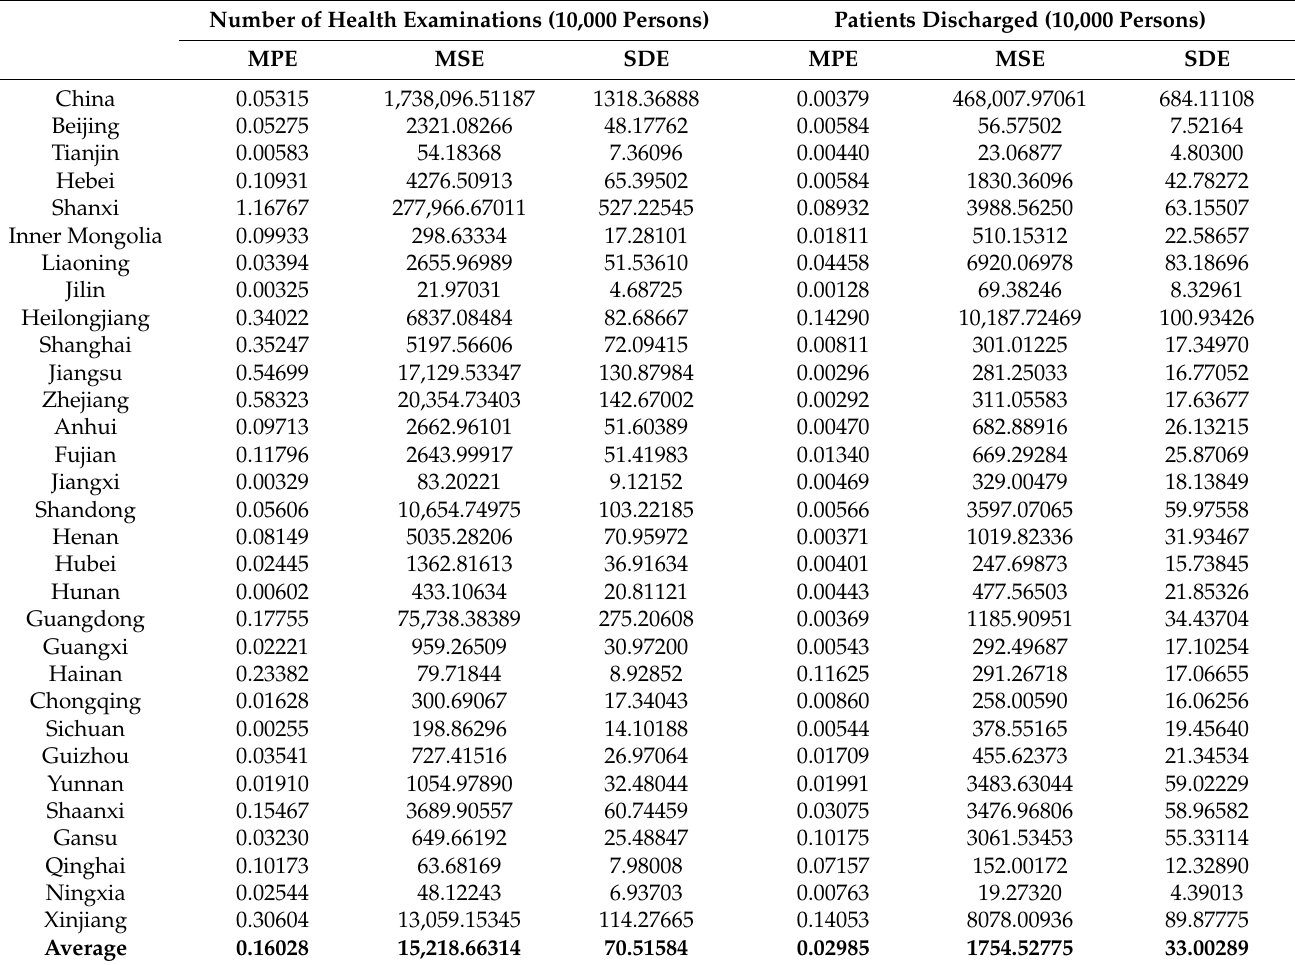
Table 2. The Second Part of Forecasting performance of LS-SVM-FM (1).